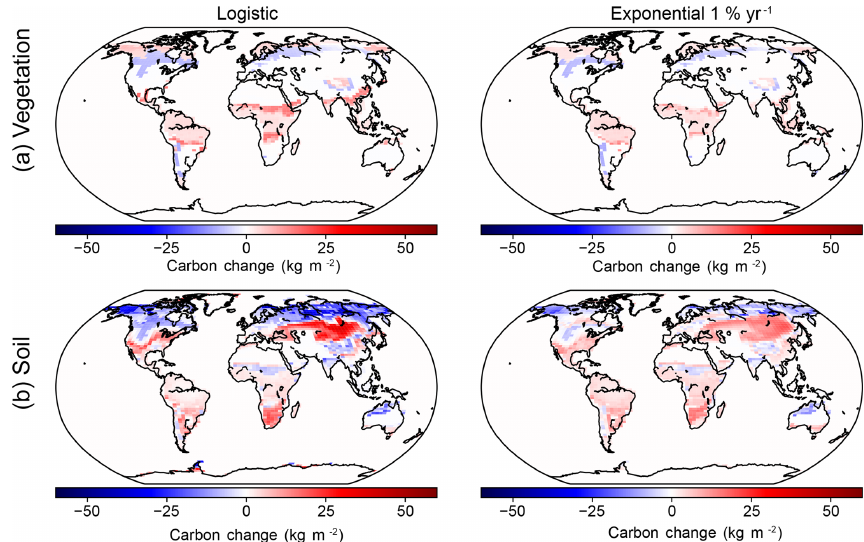
Figure 5. Change in carbon content (per unit area) between pre-industrial conditions and 2 × CO 2 concentration for UVic ESCM simulations forced with the logistic and 1% experiments: (a) changes in vegetation carbon; (b) changes in soil carbon.